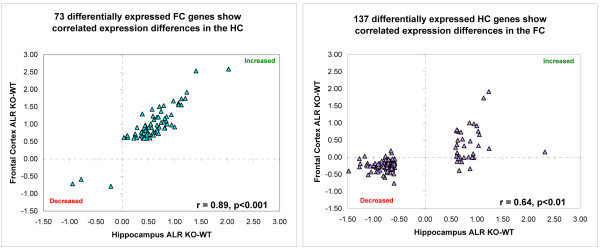
HC and FC expression changes are highly correlated. Both plots denote the ALRPSKO-CNT in the HC (X axis) and FC (Y axis). Each blue diamond represents a single, differentially expressed gene probe. Red dashed line denotes linear regression of the dataset. A. PSKO FC samples reported 70 genes differentially expressed form the FC of CNTs. These genes also showed a highly correlated expression pattern in the HC comparison (Pearson r = 0.89, p < 0.001) B. PSKO HC samples reported 53 genes differentially expressed form the HC of CNTs. These genes also showed a highly correlated expression pattern in the FC comparison (Pearson r = 0.67, p < 0.005).